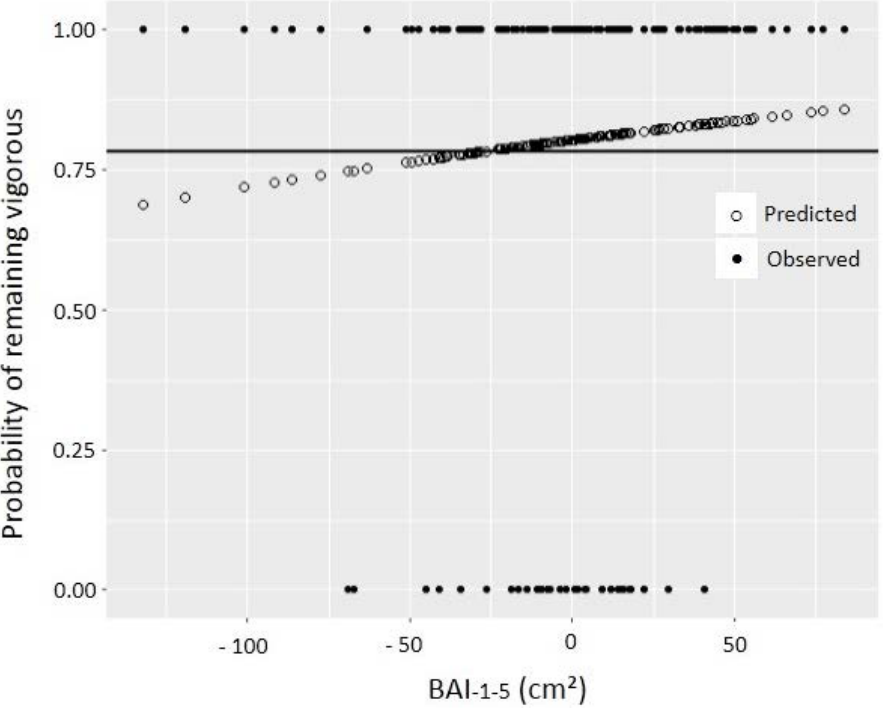
Figure 3. Probability that a vigorous tree at the first evaluation period either becomes non-vigorous (0) or remains vigorous (1) at the second evaluation period as a function of the growth-based